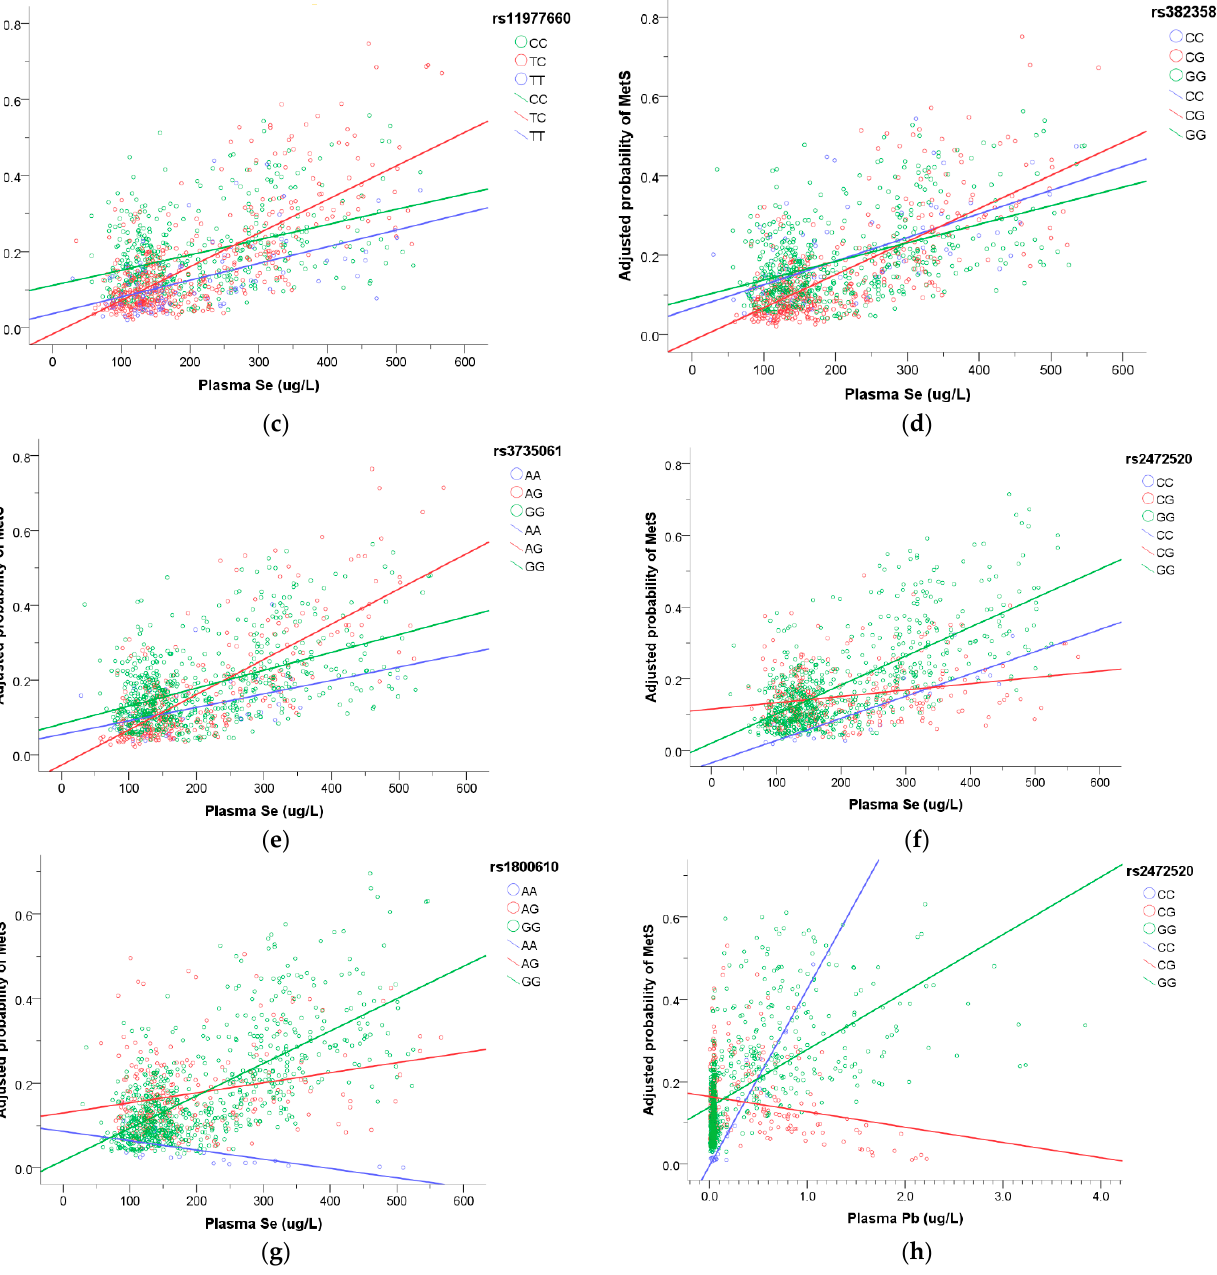
Figure 5. The association of plasma metals with the risk of MetS modified by SNPs. The regression model was built as logit [p(MetS)/1 − p(MetS)] = β 0 + β M, j M j + β SNP,1 i SNP 1 i + β SNP,2 i SNP 2 i + β int,1 i M j x SNP 1 i + β int,2 i M j x SNP 2 i + β c Covariates + ε . Adjusted covariates included age, gender, smoking, and drinking alcohol. ( a ) The risk of MetS was much higher in rs11977388 CT genotype with increasing plasma Co. ( b ) Increasing plasma Zn with higher risk of MetS, especially in rs3735061 AG genotype. ( c ) Increasing plasma Se with higher risk of MetS, especially in rs11977660 TC genotype. ( d ) Increasing plasma Se with higher risk of MetS, especially in rs3823585 CG genotype. ( e ) Increasing plasma Se with higher risk of MetS, especially in rs3735061 AG genotype. ( f ) Increasing plasma Se with higher risk of MetS but the least elevated risk in rs2472520 CG genotype. ( g ) The risk of MetS reduced in rs1800610 AA genotype with increasing plasma Se. ( h ) The risk of MetS decreased in rs2472520 CG genotype with increasing plasma Pb.